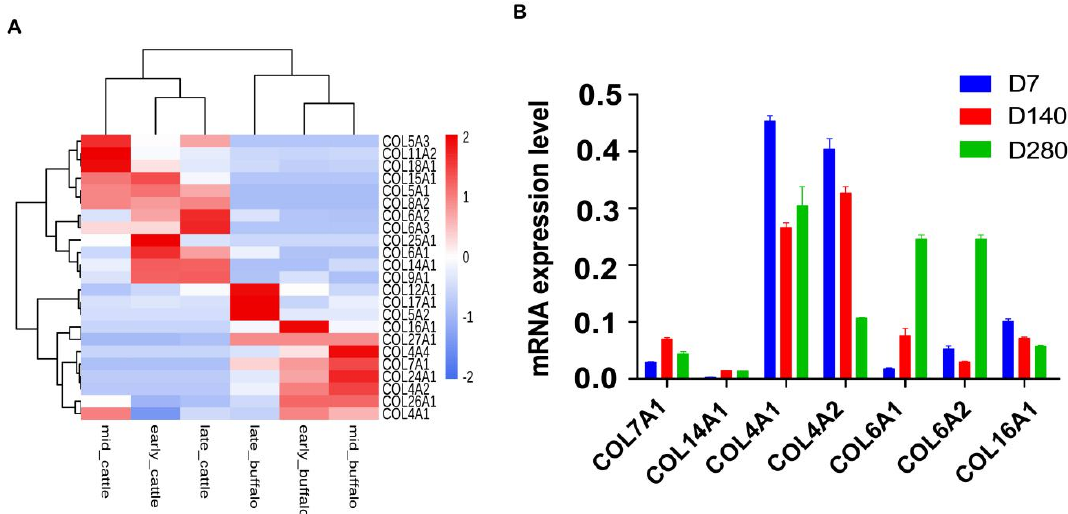
Figure 5. Heat map ( A ) of orthologous collagen genes of cattle and buffalo and validation of selected buffalo collagens by qRT-PCR ( B ). Distances, representing the relative similarity among genes and tissues, were calculated using Pearson’s correlation coefficients. Color represents the TPM (transcripts per million) values of gene expression after scaling and centering. D7 indicates early lactation, D140 indicates mid-lactation, and D280 indicates late lactation.